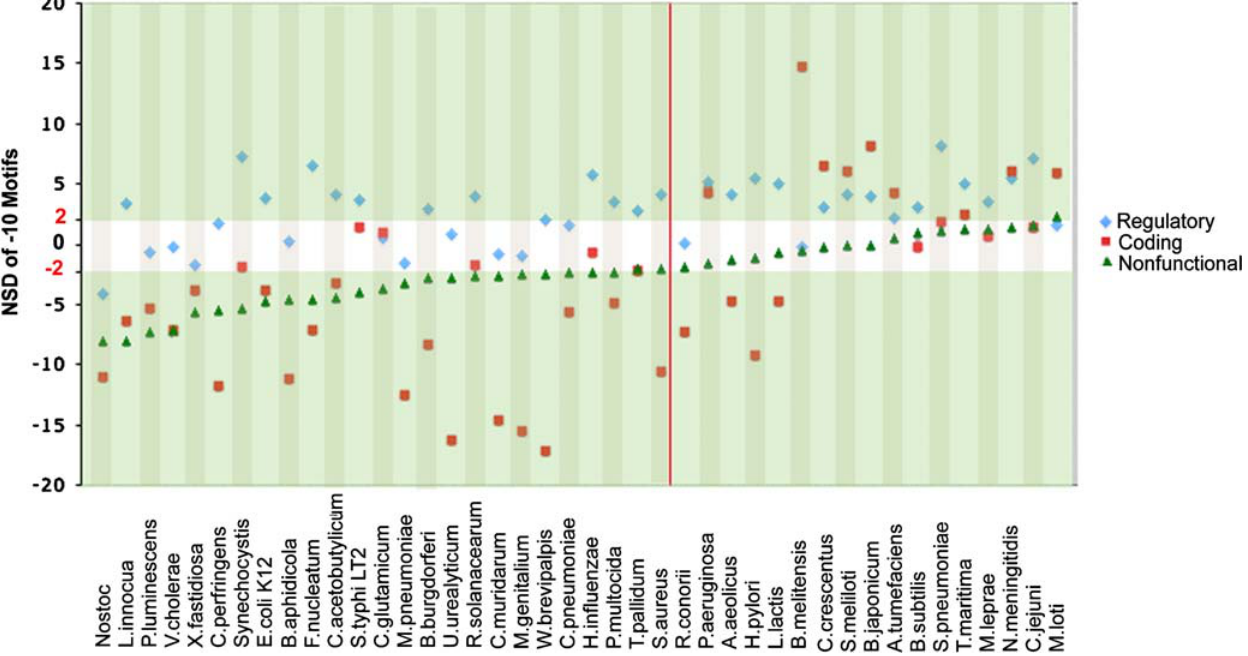
Figure 4. Deviations in the observed counts of 2 10 motifs in different genomic regions. NSD values measure the deviation in the observed counts of 2 10 motifs in numbers of standard deviations from the expected mean in the corresponding genome, and were obtained by comparing observed counts to distributions of motif frequencies in shuffled sequences. Species are ordered according to ascending NSD values for the nonfunctional regions. NSD values in the white band are not significantly different from expectation. The red line separates species with under-representation of 2 10 sites in nonfunctional regions (left) from those without (right).